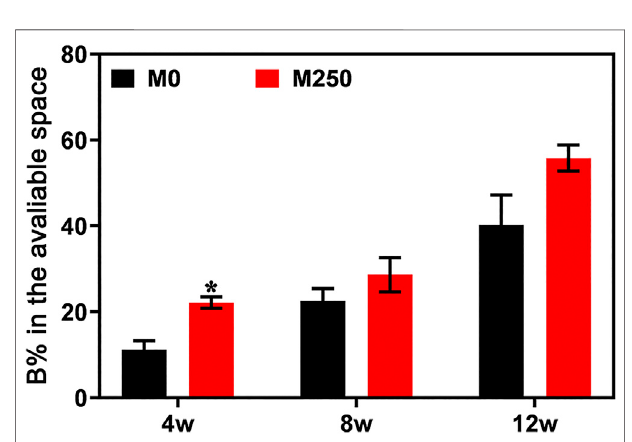
FIGURE 9 | Bone formation in the available space (%) of samples harvested from rabbits (statistically signi fi cant differences are marked by * p < 0.05, ** p <